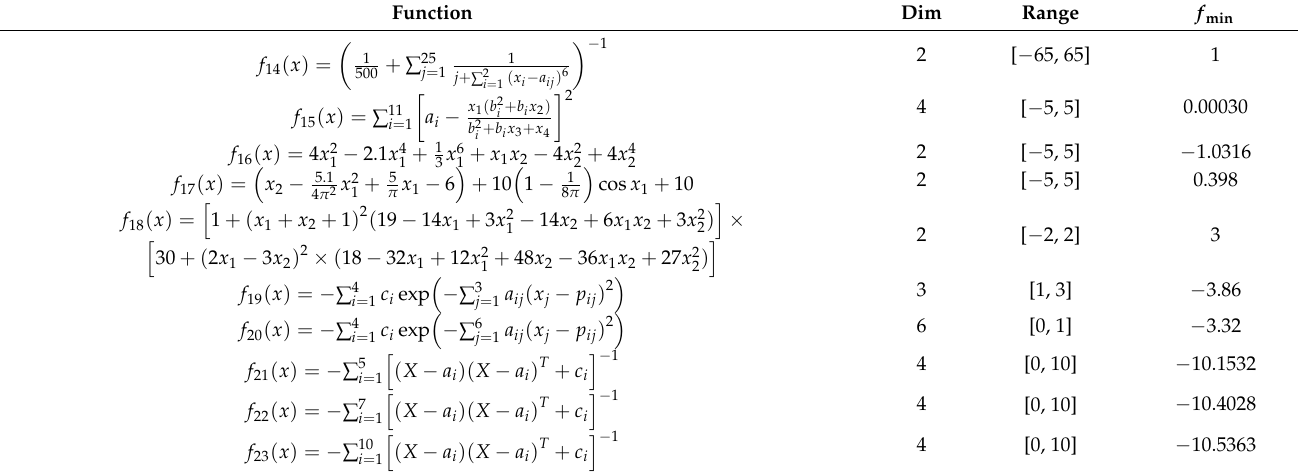
Table 3. Fixed-dimension multimodal benchmark